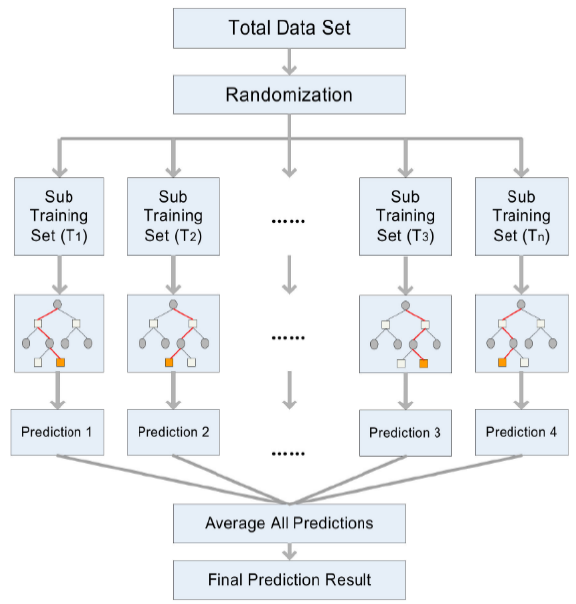
Figure 4. Conceptual diagram of the random forest (RF).